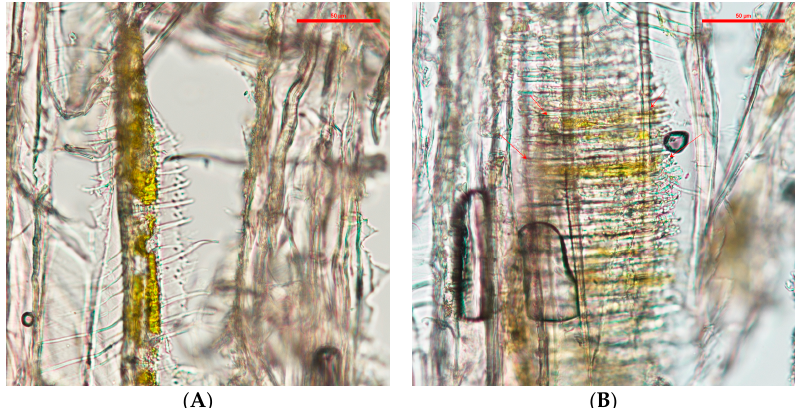
Figure 3. ( A ) Vessels of cottonwood with extracted pigment of S. ganodermophthorum accumulating on the cell walls; ( B ) Pigments of S. ganodermophthorum between the helical thickenings, pointed to with arrows. Picture taken with a Nikon Eclipse Ni-U at 20× magnification.